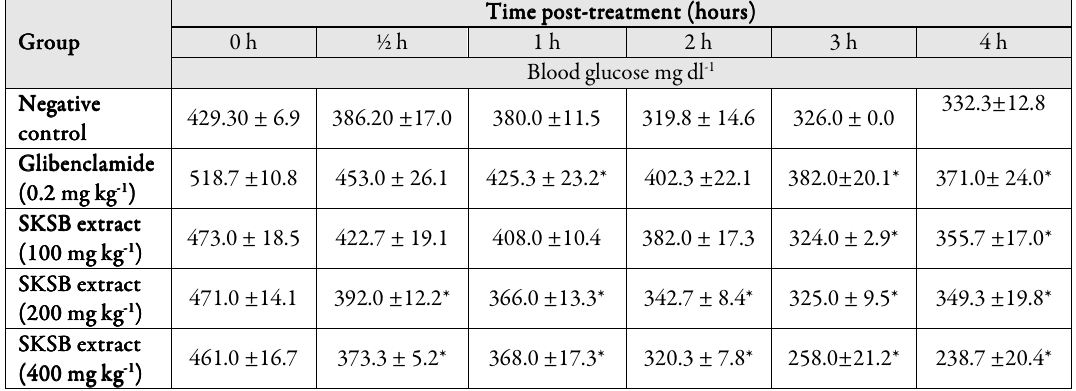
Table 3. Effects of SKSB extract on blood glucose level of Streptozotocin-induced diabetic rats Group